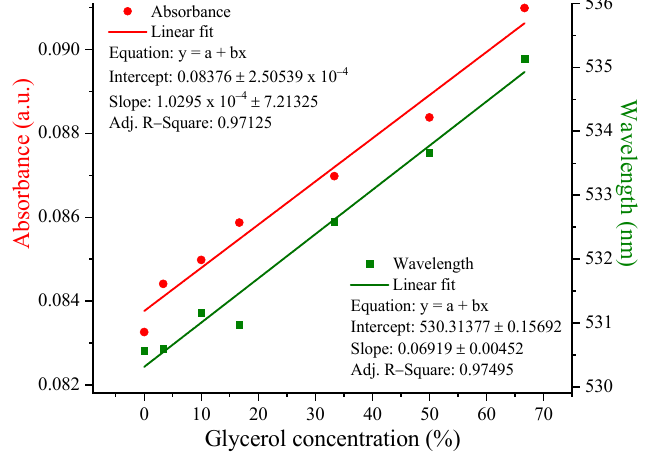
Figure 10. The UV-Vis maximum and wavelength dependence on glycerol concentrations for the P 0.12 sample.